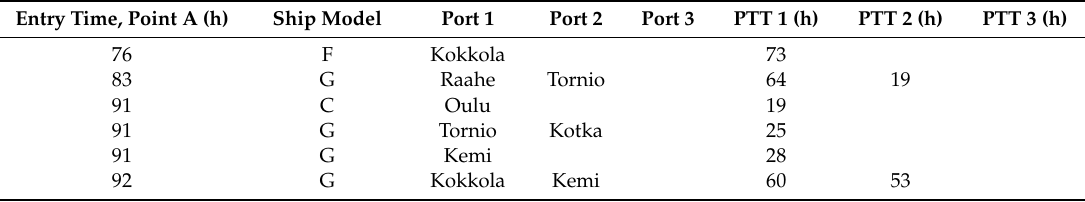
Table 1. Extract of maritime tra ffi c data. The port turnaround time (PTT) represents the total duration of a port visit including port maneuvering time, mooring time, and cargo handling